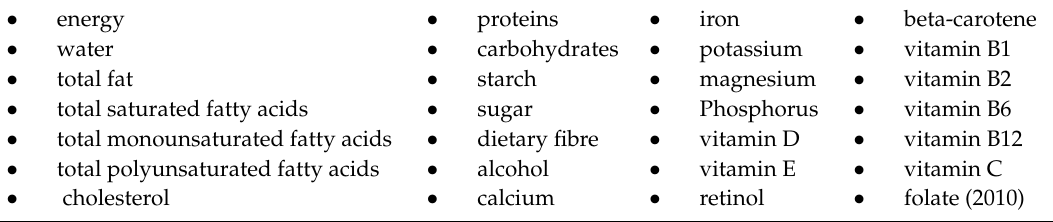
Table 1. List of the 28 nutrients included the European prospective investigation into cancer and nutrition (EPIC) nutrient database